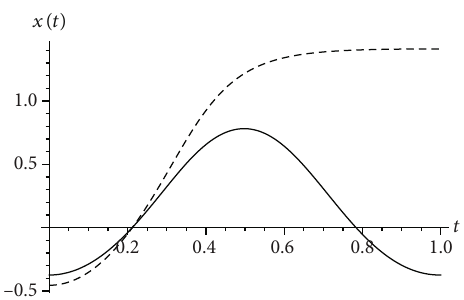
Figure 15: Graphs x ð t Þ for solutions of problems (15) and (30), x α ≈ − 0 : 375 , x α ≈ − 0 : 45568 (dashed).